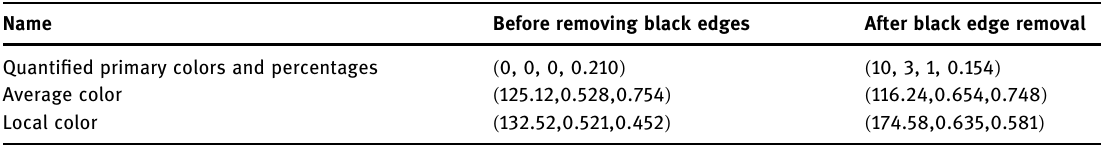
Table 1: Comparison of color eigenvalues before and after black edge removal in images